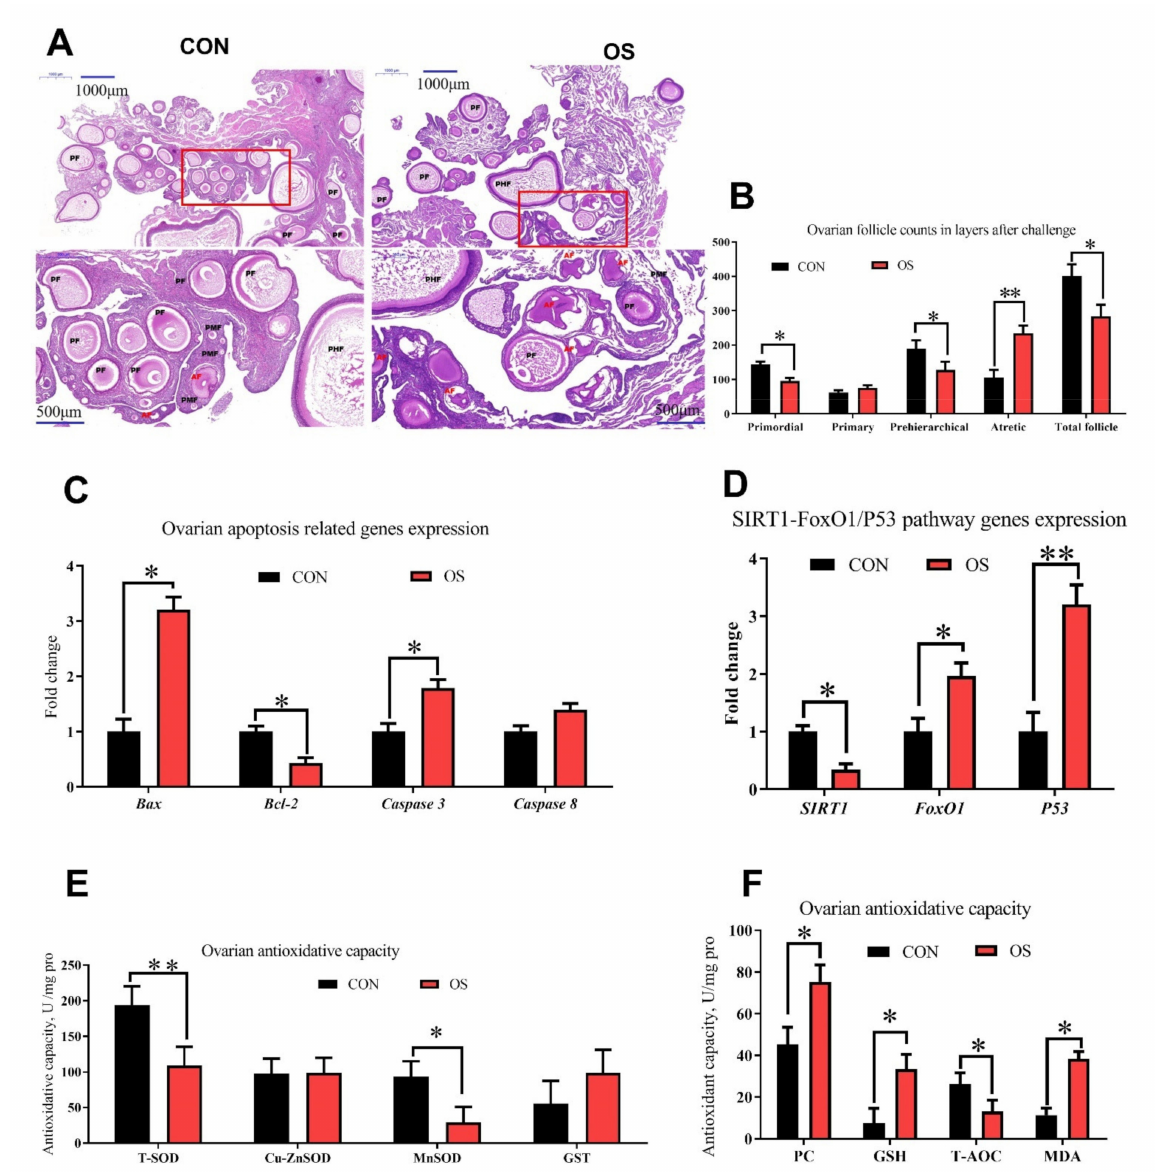
Figure 2. Oxidative stress (induced by tBHP) decreased ovary function (Experiment 1). ( A , B ) Ovarian histology of layers after 24 days treatment and follicle numbers at each developmental stage (PMF = primordial follicle; PF = primary follicle; PHF = prehierarchical follicle; AF = atretic follicle). ( C , D ) RT-PCR analysis for mRNA expression levels related to ovarian follicular apoptosis and antioxidant related gene expression. ( E , F ) Antioxidant capacity analysis for ovary with antioxidant enzyme activities and oxidation product. Data are means ± SEM represented by vertical bars or plot individual values ( n = 10) ± SEM. CON = same dosage of PBS, OS = 800 µ mol/kg BW of tBHP, Bcl-2 = B-cell lymphoma-2, SIRT1 = sirtuin 1, FoxO1 = forkhead box O1, T-SOD = total superoxide dismutase, GST = glutathione S transferase, PC = protein carbonyl, GSH = glutathione, T-AOC = total antioxidant capacity, MDA = malondialdehyde. Statistical significance was evaluated by t -test, * p < 0.05, ** p <